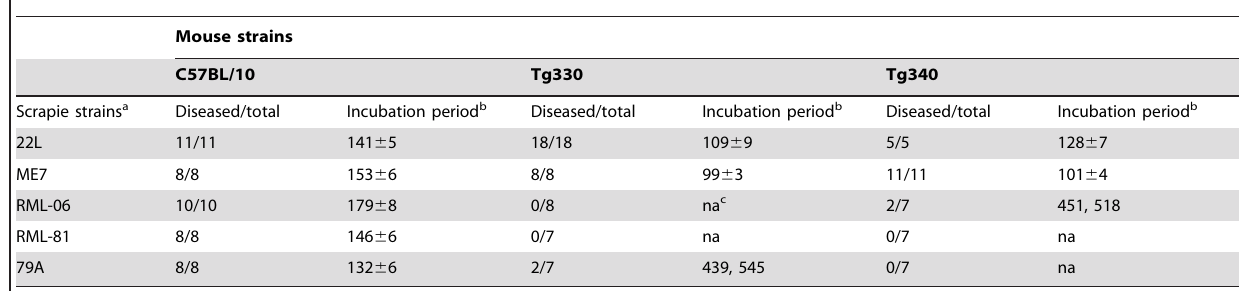
Table 2. Susceptibility of transgenic and C57BL/10 mice to four strains of scrapie.